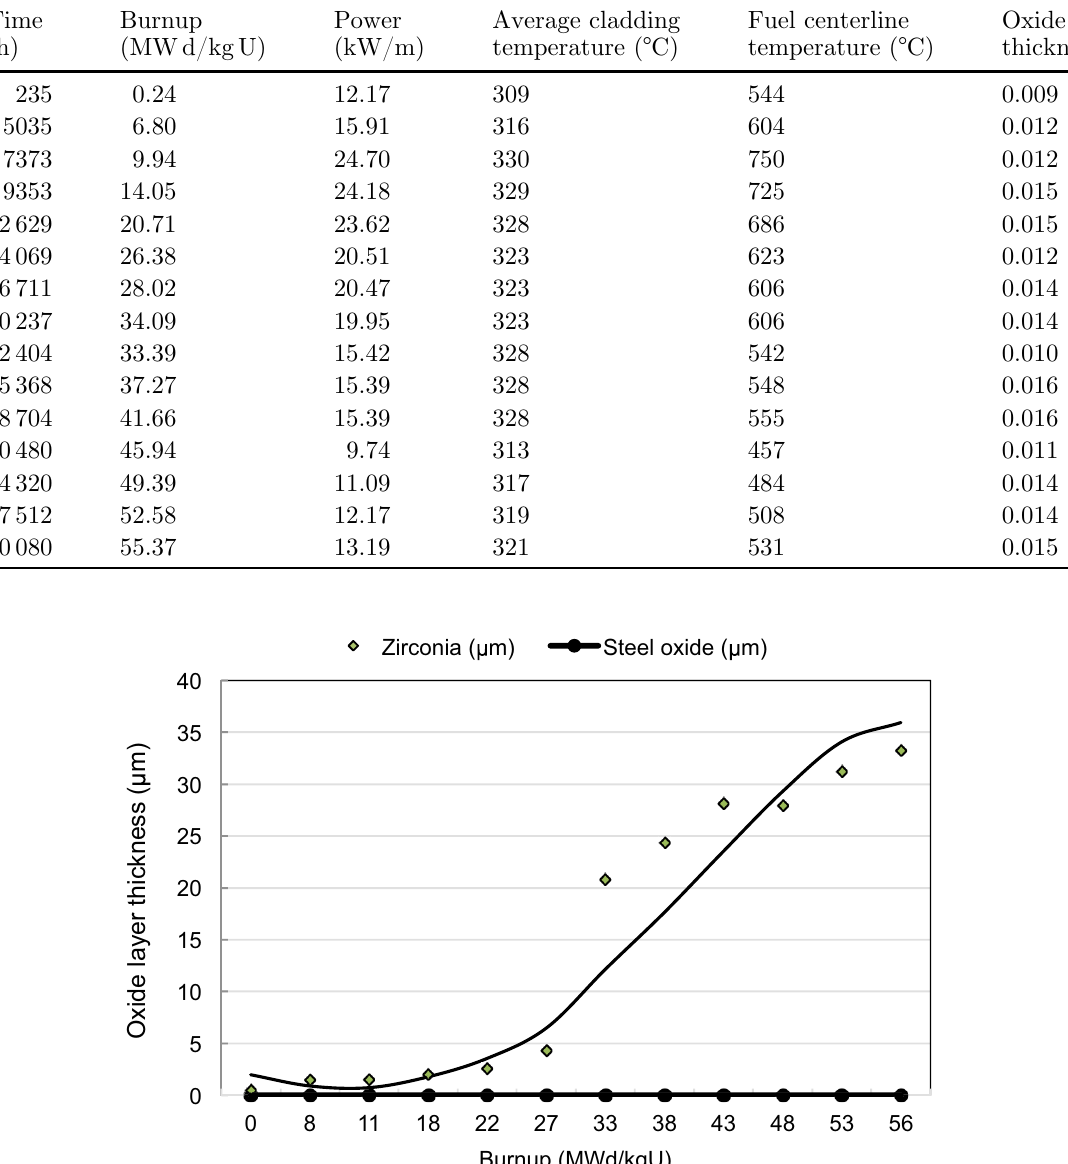
Table 5. Data obtained from simulation for SS fuel rod using IPEN-CNEN/SS2. Time